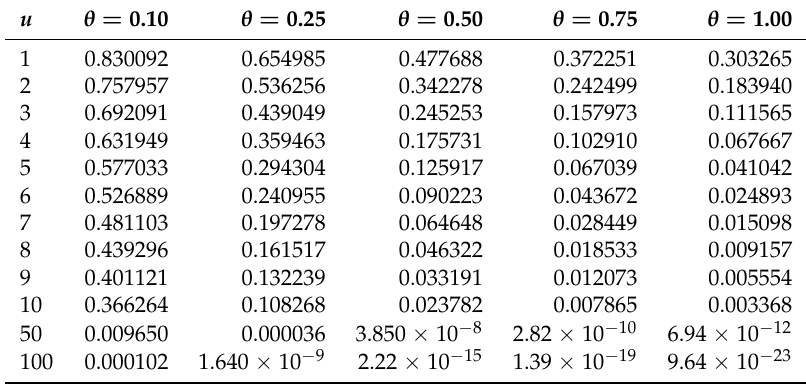
Table 2. Ruin probabilities for exponential claims with λ = 1 and different values of the premium loading factor θ . u θ =